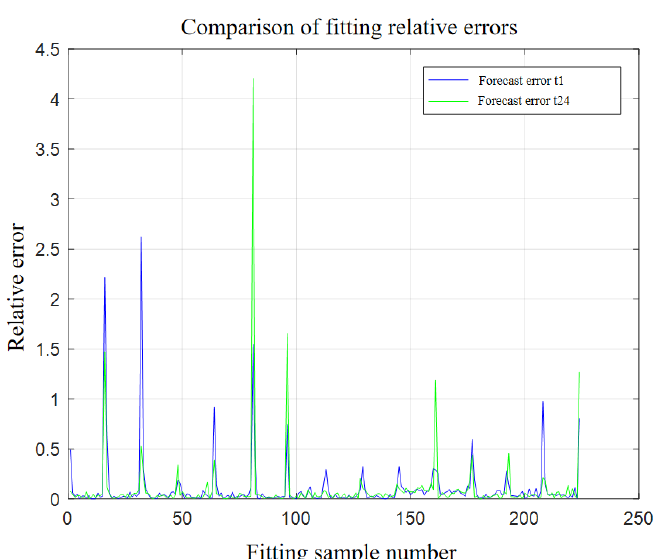
Figure 42. The comparison of the relative error of fitting the training set.